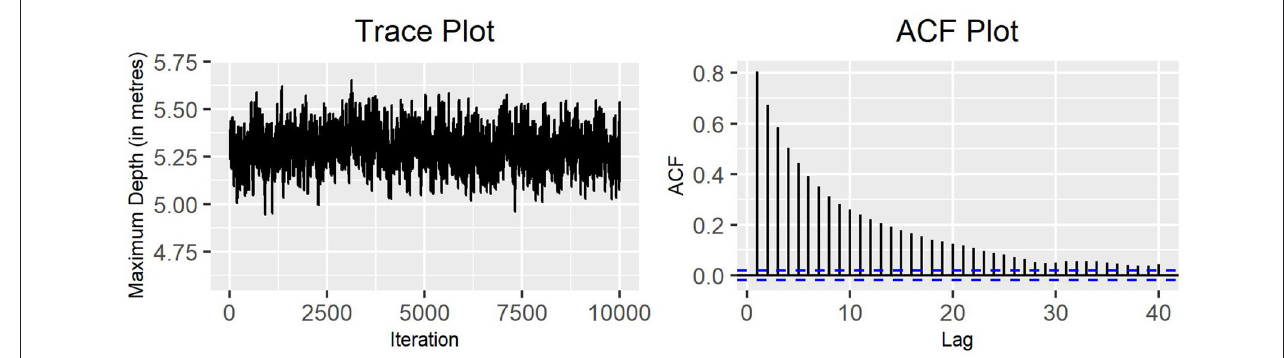
FIGURE 8 | Single-update MH algorithm for the complete parameter set: trace plot and ACF plot of the standard deviation of the variable maximum depth for production state 2 (10,000 iterations).